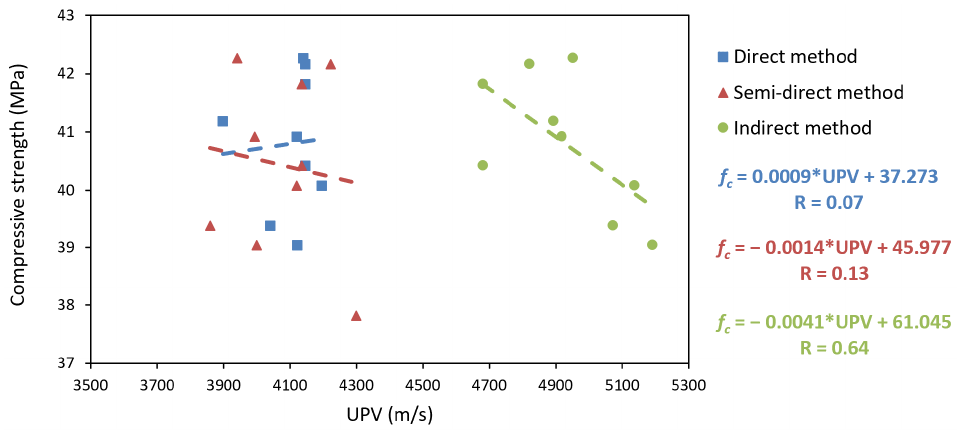
Figure 14. Correlation between ultrasonic pulse velocity and compressive